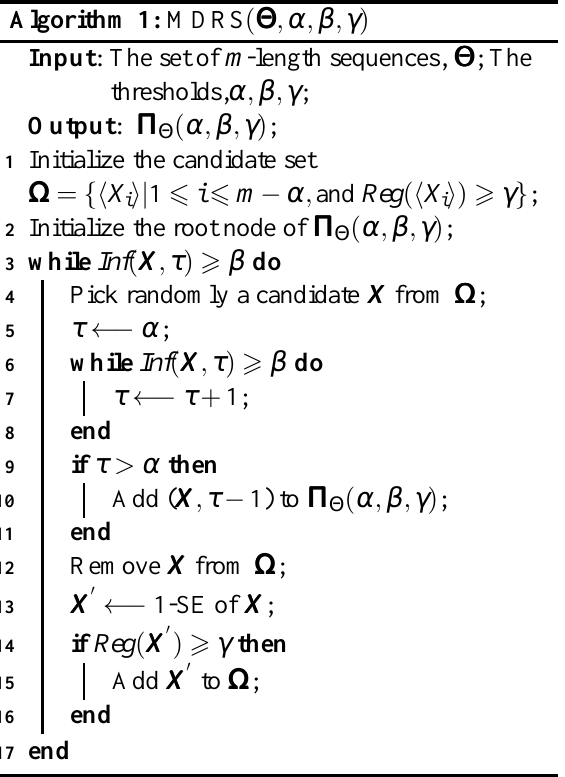
Algorithm 1: MDRS ( QQQ , a , b , g